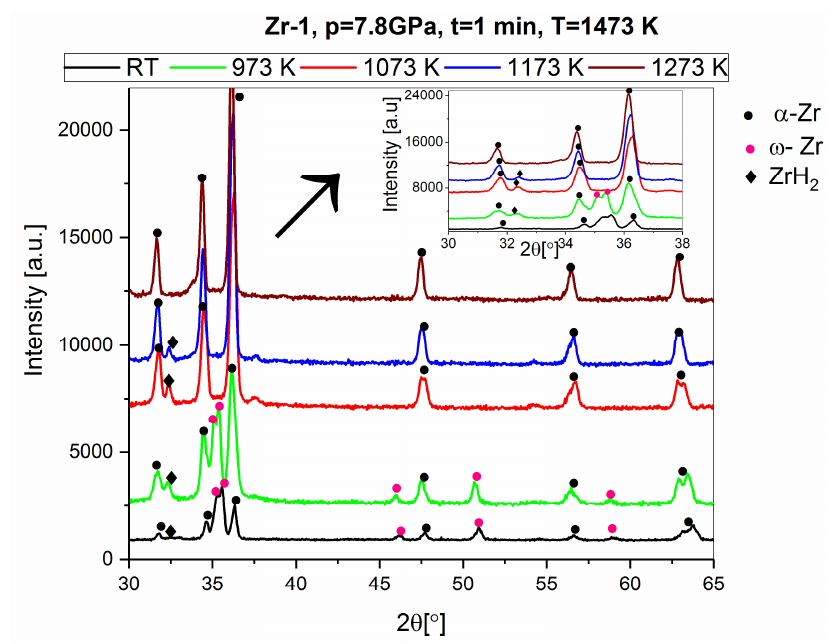
Figure 12. The X-Ray pattern for the heat treatment in the HTK2000 device of the Zr 1 high-pressure material sintered at 1473 K. Table 9. The qualitative and quantitative phase composition (wt. %) after heat treatment in the HTK2000 device of the Zr 1 material high-pressure sintered at 1473 K.